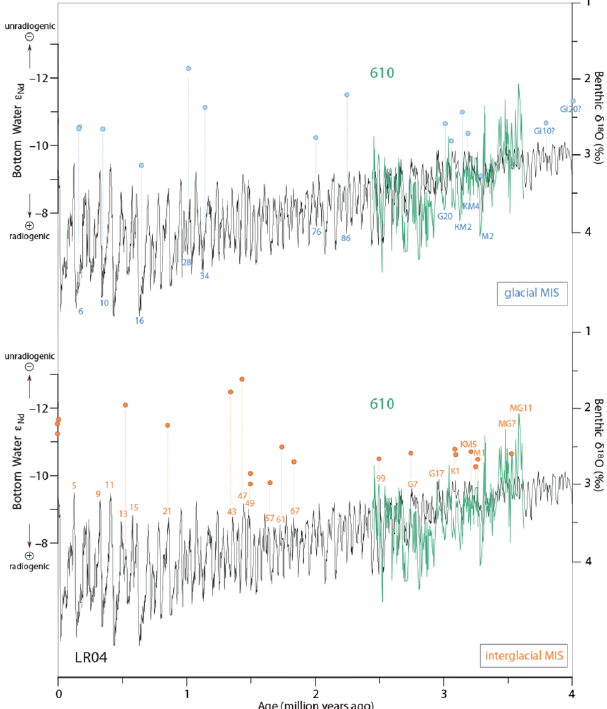
Figure 6. Comparison between changes in bottom-water ε Nd sig- natures and benthic foraminiferal δ 18 O values at site 610 and the global benthic foraminiferal δ 18 O stack LR04 of Lisiecki and Raymo (2005) for glacial (blue dots) and interglacial (red dots) ma- rine isotope stages (MIS) during the last 4 million years (benthic δ 18 O data at site 610 are from Kleiven et al., 2002 using the age model of De Schepper et al.,